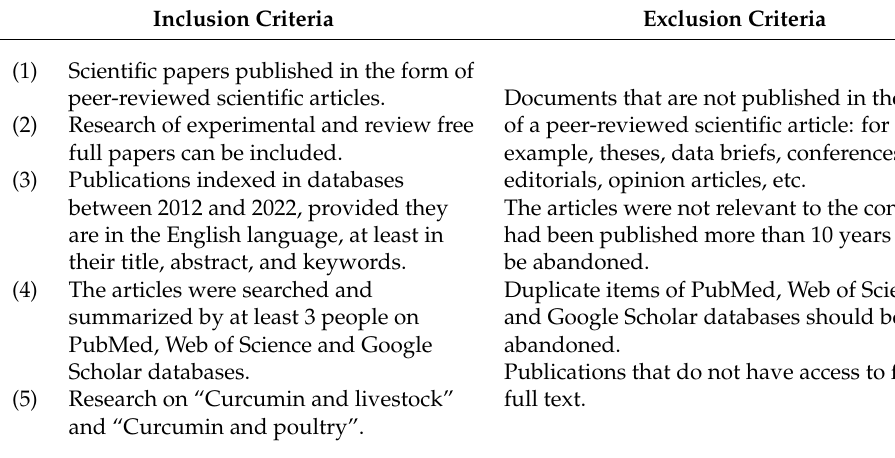
Table 1. Inclusion and Exclusion